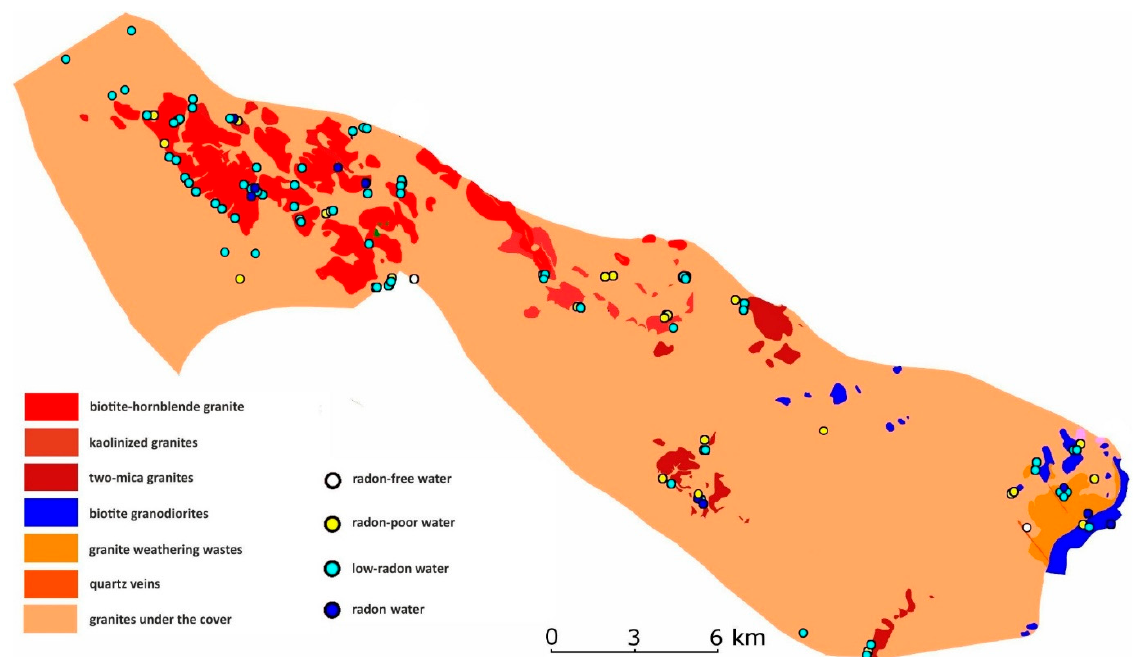
Figure 3. Strzegom-Sob ó tka granitoids. Groundwater sampling sites plotted together with the types of collected water by 222 Rn content according to Przylibski’s classification